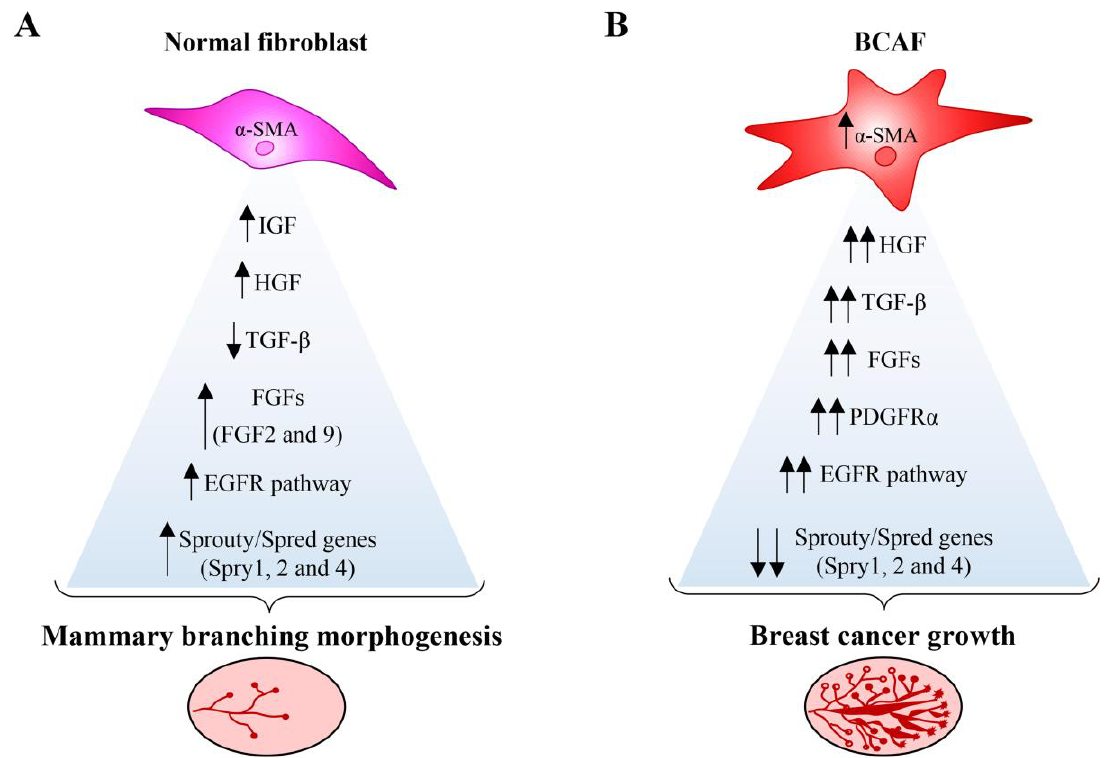
Figure 2. Role of fibroblasts in mammary gland branching and BC growth. Mammary branching morphogenesis and BC growth share many cellular processes, including epithelial cell proliferation, migration, invasion, and extracellular matrix (ECM) remodeling. These similarities explain why many morphogenic processes induced by fibroblasts are exploited intensively also in BC. ( A ) In normal conditions, fibroblasts guide mammary epithelial branching through paracrine signals that are mediated by growth factors, such as insulin-like growth factor (IGF), hepatocyte growth factor (HGF), fibroblast growth factor (FGF)2, and FGF9, low concentrations of transforming growth factor (TGF)- β and tightly regulated activation of the epithelial growth factor receptor (EGFR) signaling pathway. The expression of Sprouty / Spred family members in stromal cells plays a very important role during mammary branching. These morphogenic processes activated by fibroblasts are tightly controlled to ensure normal mammary gland development. ( B ) However, they become dysregulated and subverted during BC. In fact, BCAFs support BC growth by increasing extensively the same morphogenic pathways required for normal gland development. BCAFs massively upregulate the platelet derived growth factor receptor (PDGFR) α and EGFR signaling pathways, and produce higher levels of FGFs, HGF, and TGF- β than normal fibroblasts. The loss of Spry genes promotes, in fibroblasts, a cancer-associated fibroblast (CAF)-like phenotype and thus leads to BC growth.